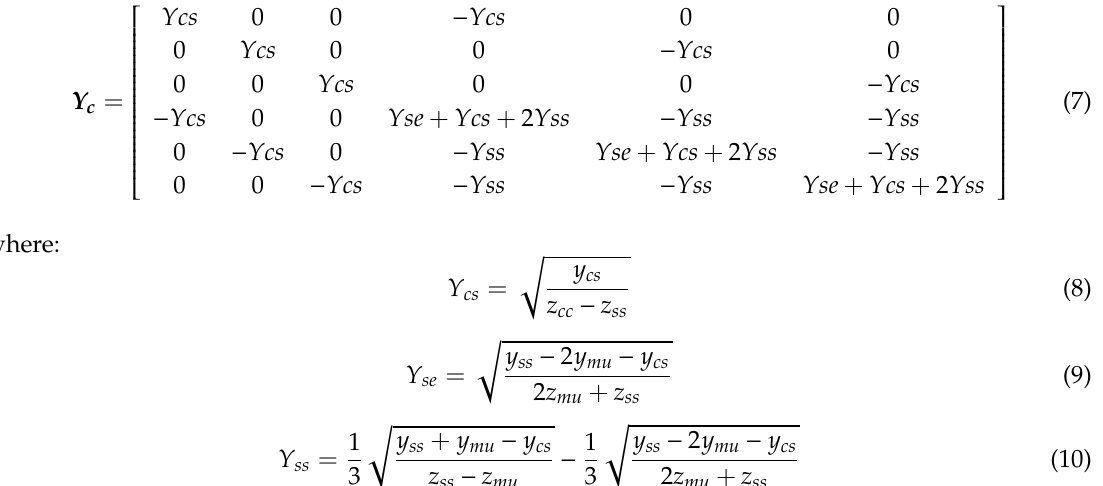
Figure 4. Relationship between the real parts of the characteristic admittances and the frequency. Table 1. Parameters of layout and cable. Laying Parameters Tunnel radius R /m